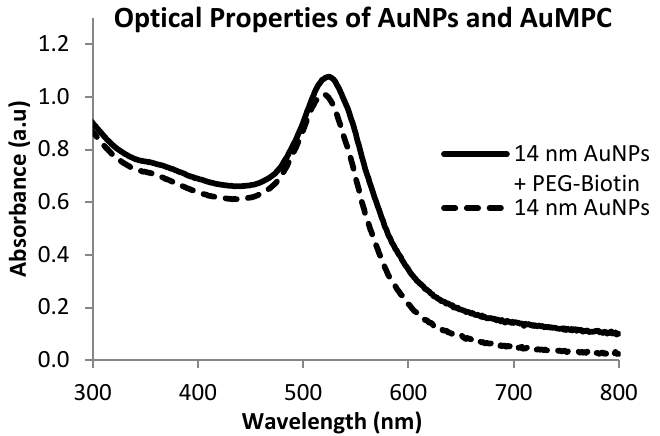
Scheme 1. PEGylation of the gold nanoparticles with biotinylated polyethylene glycol (PEG) ligand.